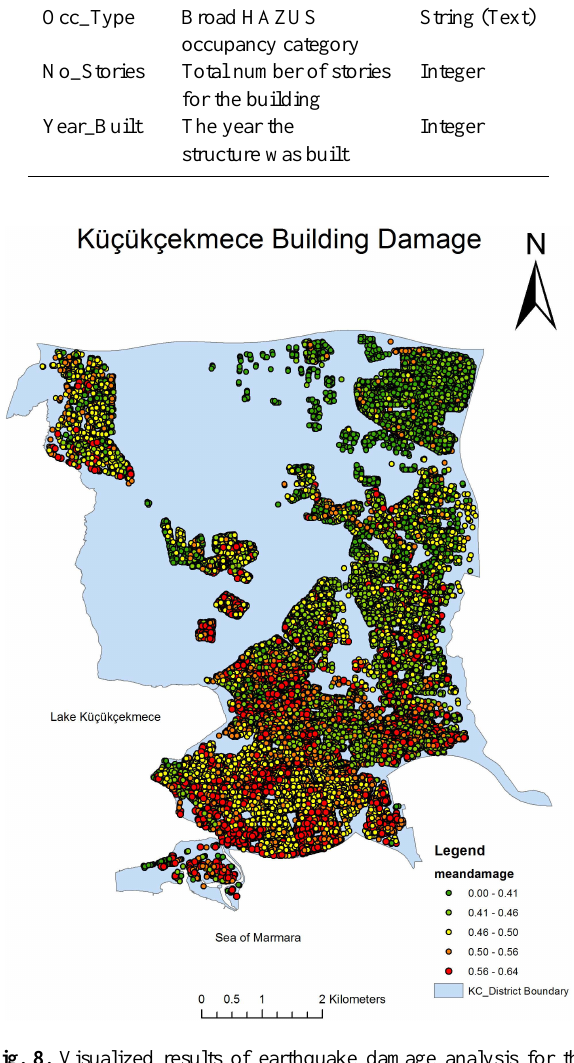
Fig. 8. Visualized results of earthquake damage analysis for the buildings.